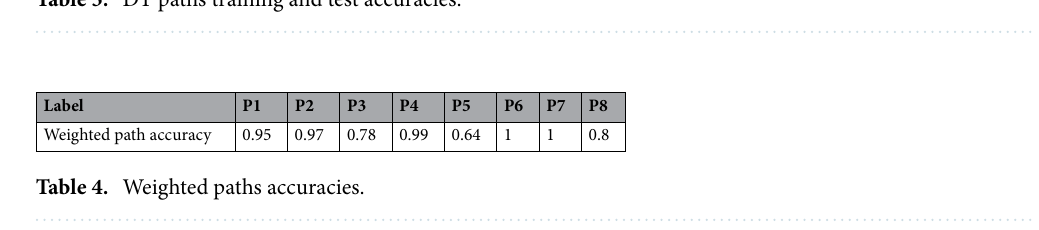
Table 3. DT paths training and test accuracies.